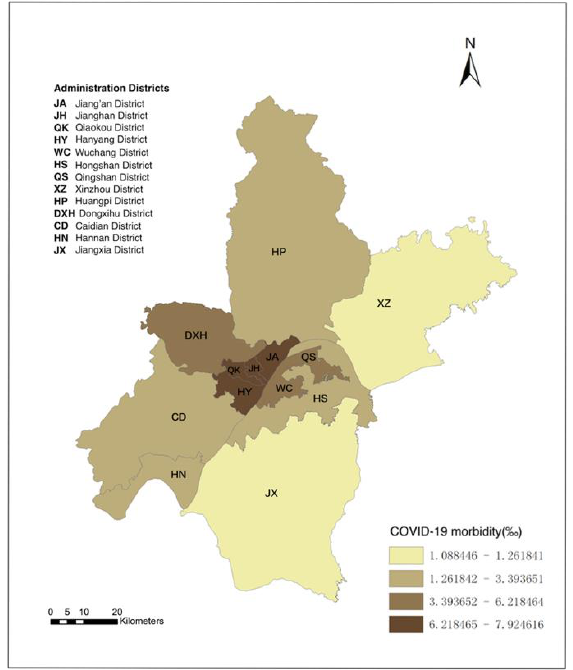
Figure 5. Spatial distribution of COVID-19 morbidity rate in Wuhan.